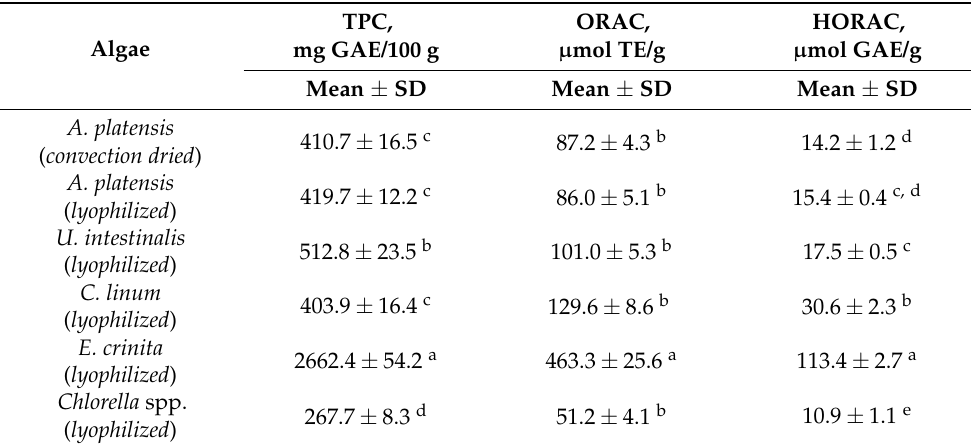
Table 5. Total phenolic content (mg GAE/100 g) and antioxidant activity of algae according to ORAC ( µ mol TE/g) and HORAC ( µ mol GAE/g). TPC, Algae mg GAE/100 g